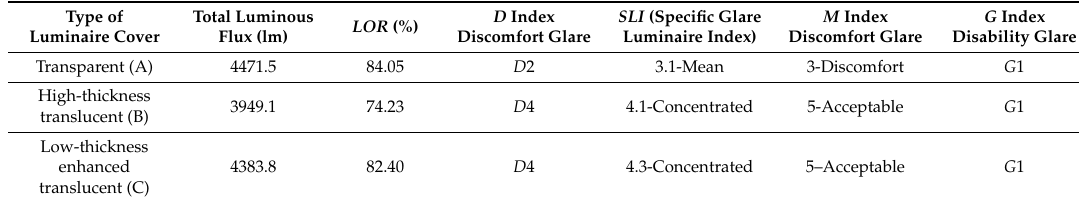
Table 5. Comparative laboratory